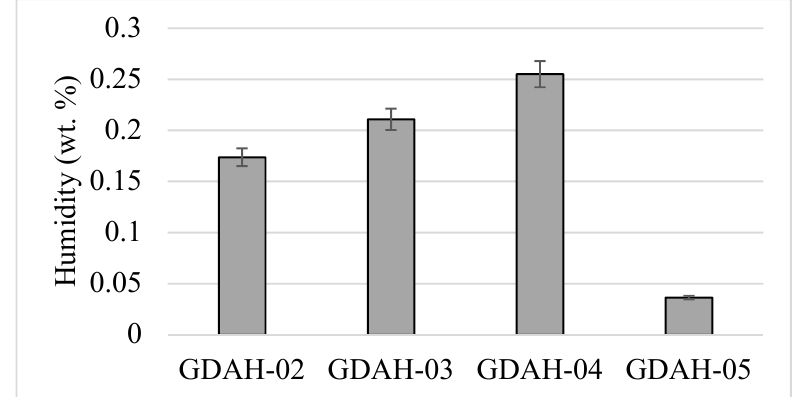
Figure 1. Humidity evaluation for the samples dried at 60 °C for 24 h.